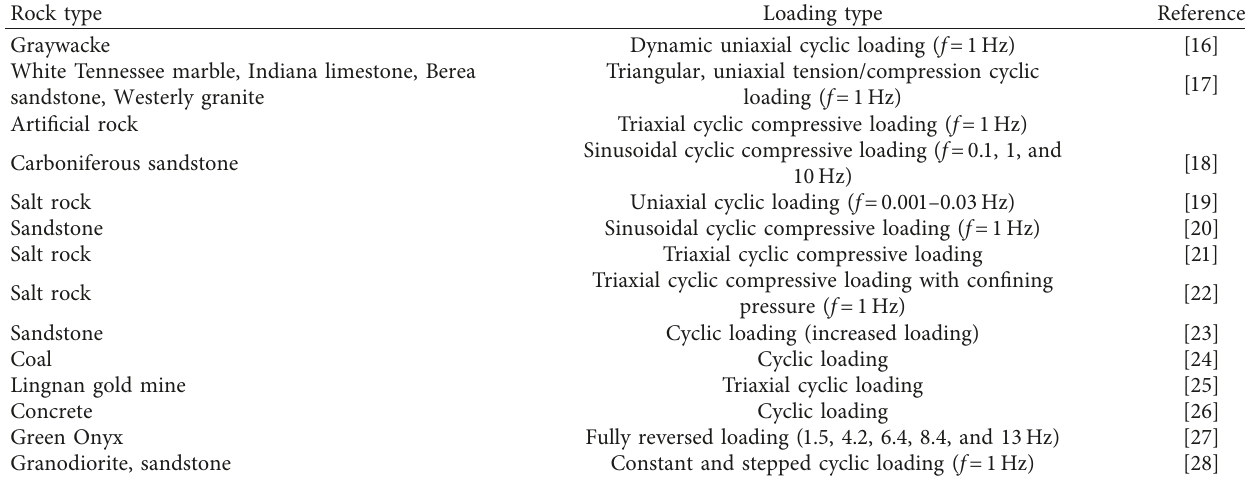
Table 1: Summary of work related to fatigue behavior on